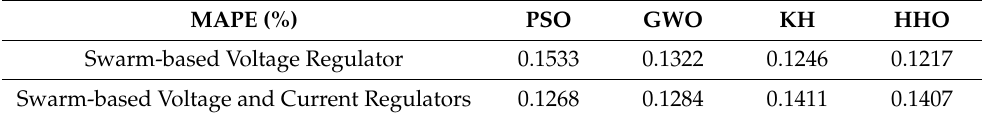
Table 3. MAPEs obtained by the four swarm-based algorithms over ten runs for Figure 20. MAPE (%)